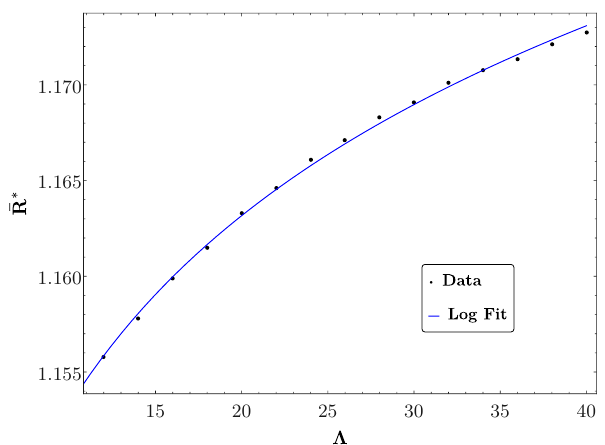
¯ R ∗ is the value of the coupling beyond which the vacuum energy in the Lee-Yang model becomes complex. The logarithmic fit is phenomenological, and the best fitting function is ¯ R ∗ = 1 . 12+0 . 01 log(Λ) . Notice that with the available range of values for Λ it is hard to